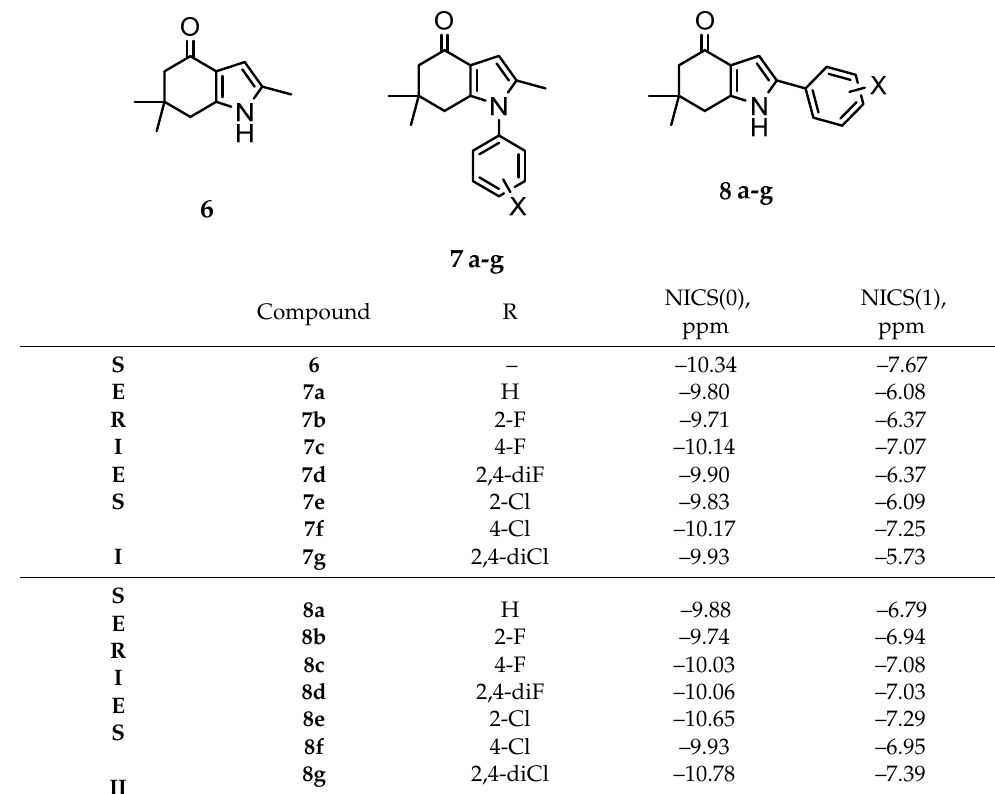
Table 1. NICS values for 15 indol-4-ones.